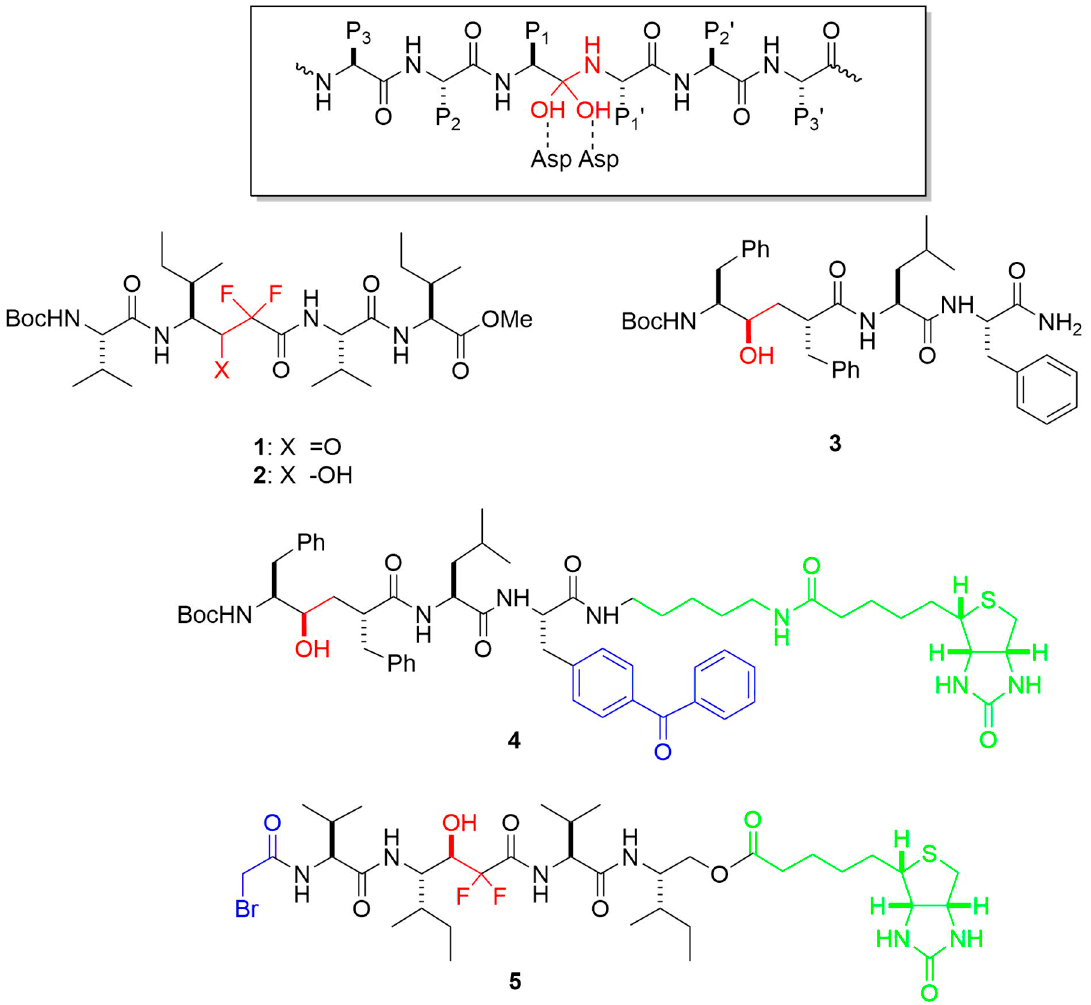
Figure 5. Representative transition-state analog inhibitors (TSAs) and affinity labeling reagents for γ -secretase. Functional groups that mimic the transition state of aspartyl protease catalysis are highlighted in red. Reactive groups leading to covalent attachment are blue, and linker-biotin moieties are in green. Boxed is the general structure of the tetrahedral intermediate formed upon addition of water to the scissile amide bond during aspartyl protease catalysis. Residues P1, P2, P3 and P1 ′ , P2 ′ , P3 ′ relative to the scissile amide bond are indicated.